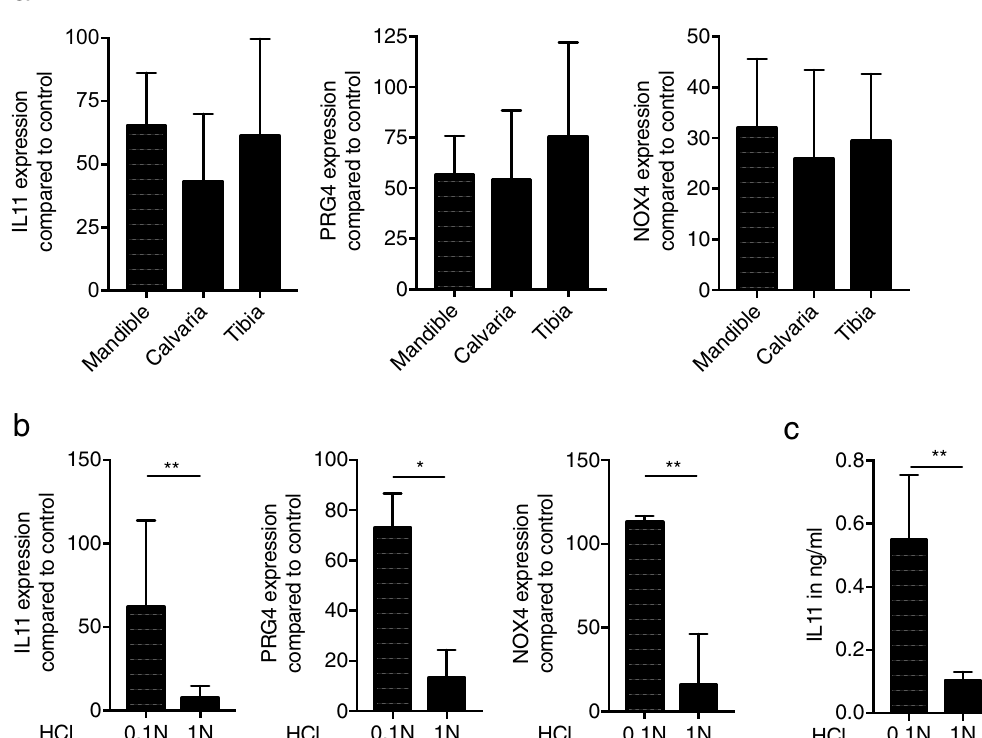
Figure 7. Acid bone lysate (ABL) obtained from mandible, calvaria and tibia produces an equivalent gene expression and TGF- β activity is highly dependent on hydrochloric acid concentration. ABL obtained from different sources (mandible, calvaria and tibia) produces a similar response on selected genes ( a ). ABL prepared with 0.1 N hydrochloric acid induces a higher TGF- β activity at mRNA level ( b ). Immunoassay of IL11 confirmed the higher activity of TGF- β at protein level with 0.1 N ABL ( c ). N = 3–5. Data represent the mean ± SD. P > 0.05, by Kruskal- Wallis test with Dunn’s multiple comparisons correction, * P < 0.05, ** P < 0.01, by two-tailed Mann-Whitney